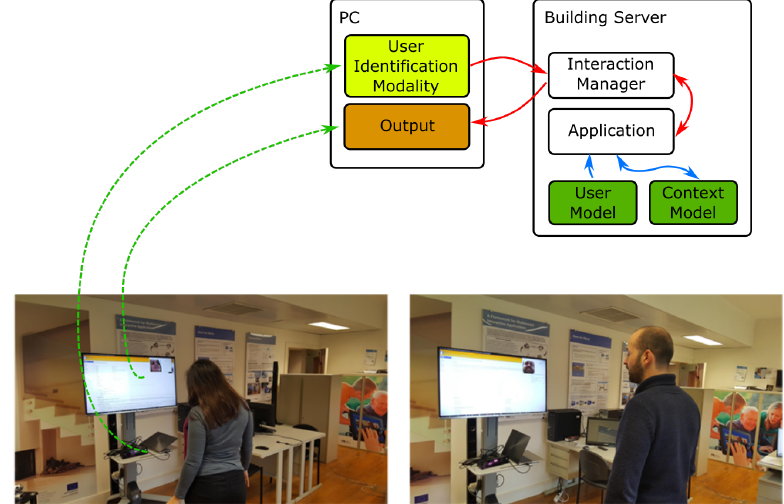
Figure 9. Photos illustrating the proof-of-concept 1, where content is shown to a lab occupant based on information regarding his/her interests. The diagram at top right depicts the main components of the A4MI Framework in